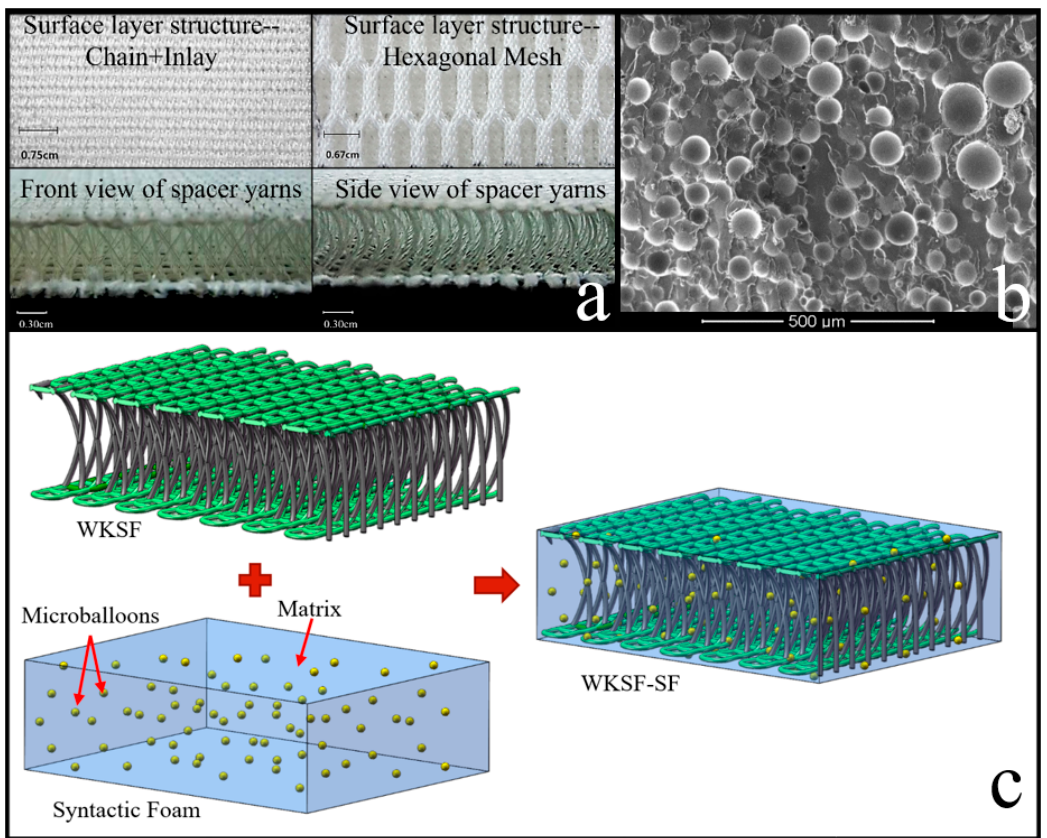
Figure 2. The structure of ( a ) WKSF, ( b ) microballoons and ( c ) schematic illustration of warp-knitted spacer fabric reinforced syntactic foam (WKSF-SF).